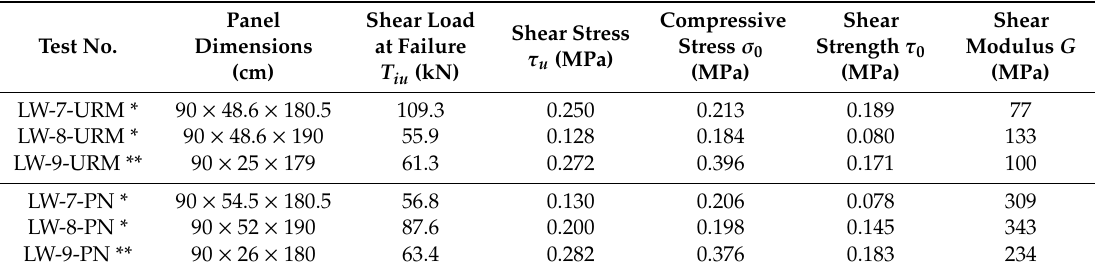
Table 7. Results of shear tests (LW panels); the results are in terms of the stresses.